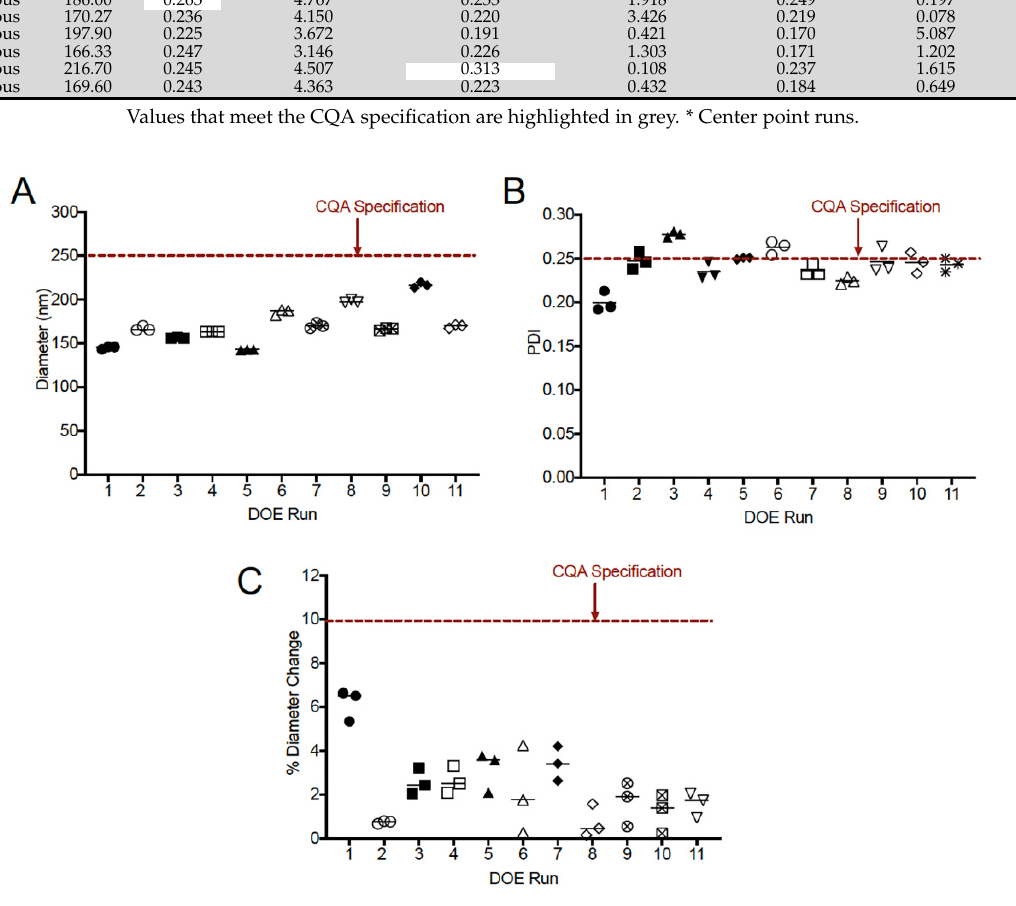
Figure 5. ( A ) Droplet diameter comparisons of the 11 DoE runs (each represented with its unique symbol); ( B ) PDI comparisons of the 11 DoE runs; and ( C ) % diameter change of DoE runs after storage for 1 week at 50 °C.